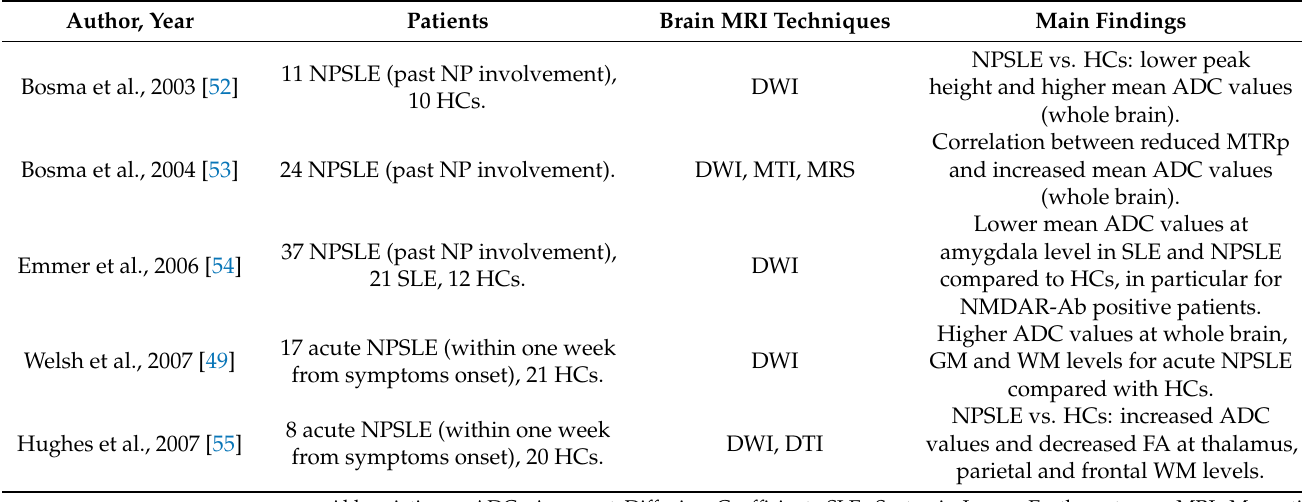
Table 3. Studies investigating quantitative ADC alterations in SLE